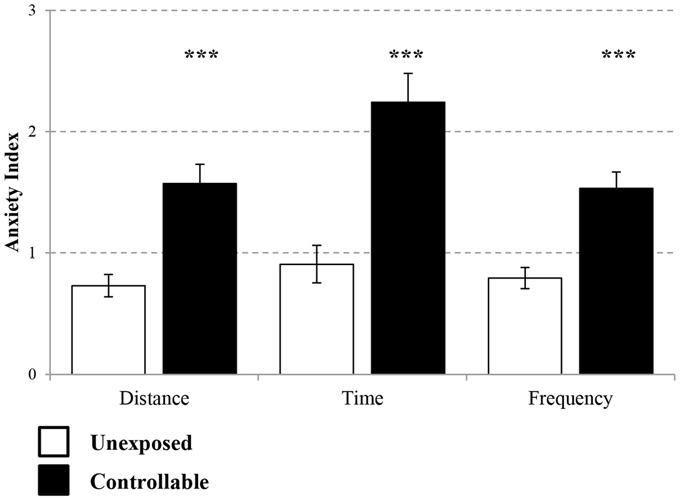
Anxiety Index levels in the EPM. Two weeks after the end of TWS training anxiety indices of distance covered, duration and frequency of entries to open vs. closed arms were measured. The controllable group displayed decreased anxiety levels in all parameters in comparison to unexposed animals. Values presented as mean ± SEM. ***significant difference between groups with p < 0.001.